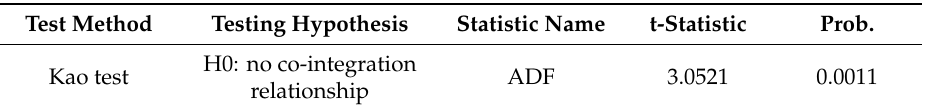
Table 4. Kao Test.